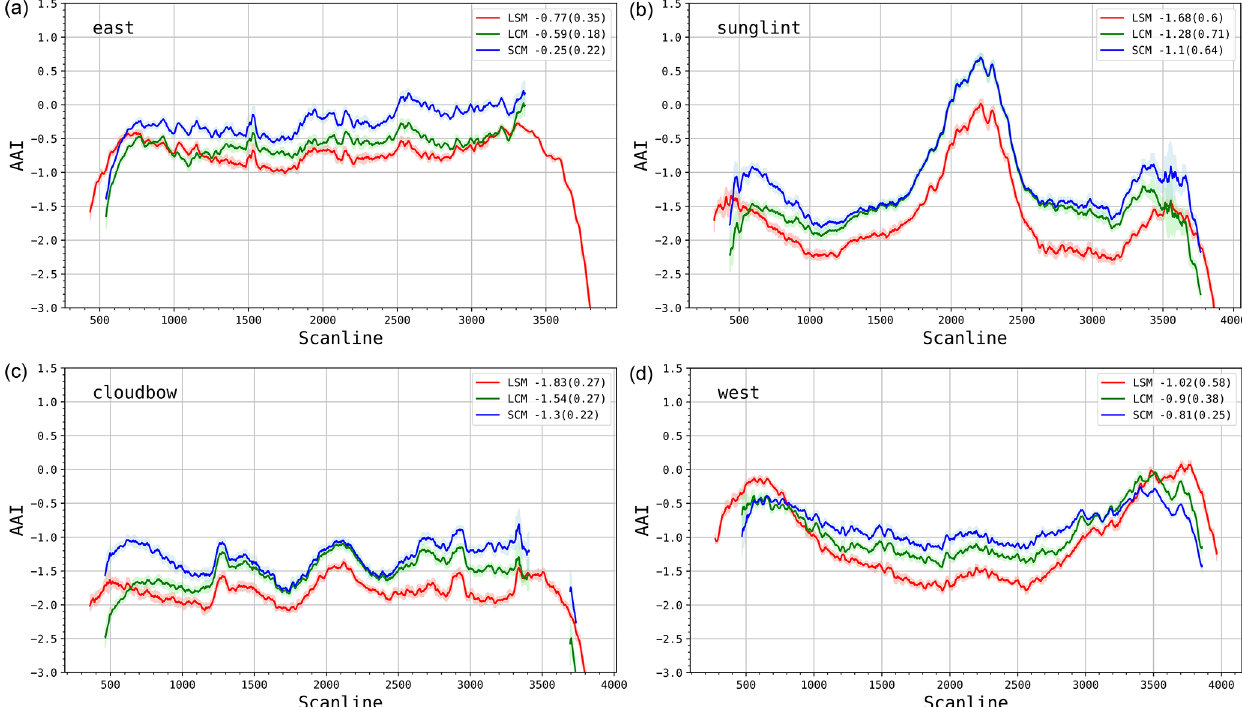
Figure 13. TROPOMI AAI as a function of scanline for the east (a) , sunglint (b) , cloudbow (c) , and west (d) north–south cross sections. The three different models are shown: LSM (red), LCM (green), and SCM (blue). The numbers in the legend show the 25-pixel rolling mean and standard deviation (between